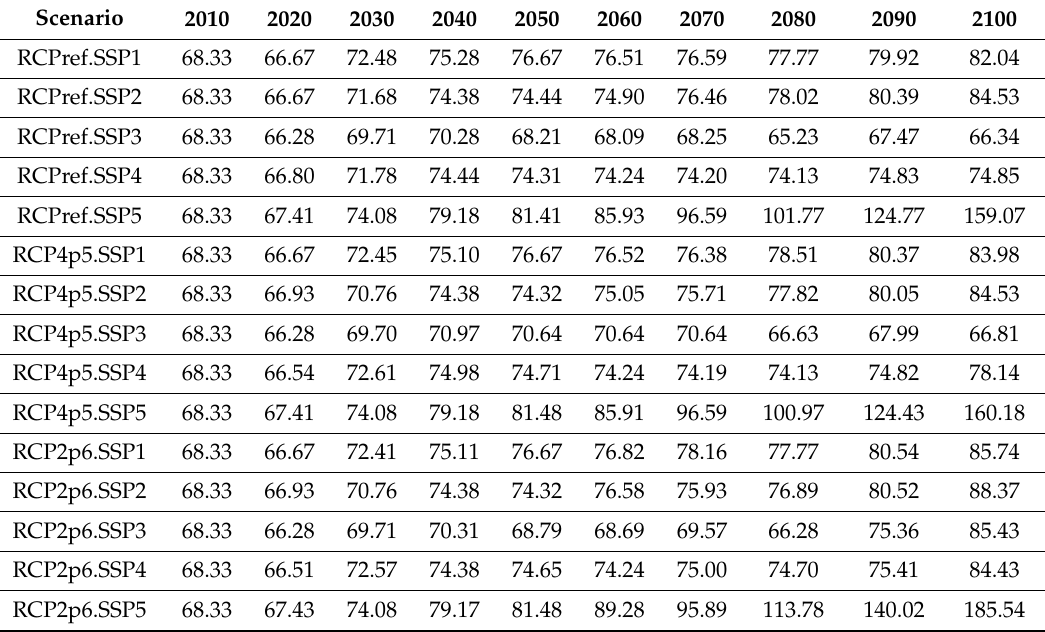
Table A24. Prices—Sawlogs (National average price per m 3 , in USD (exchange rate in 2010)).